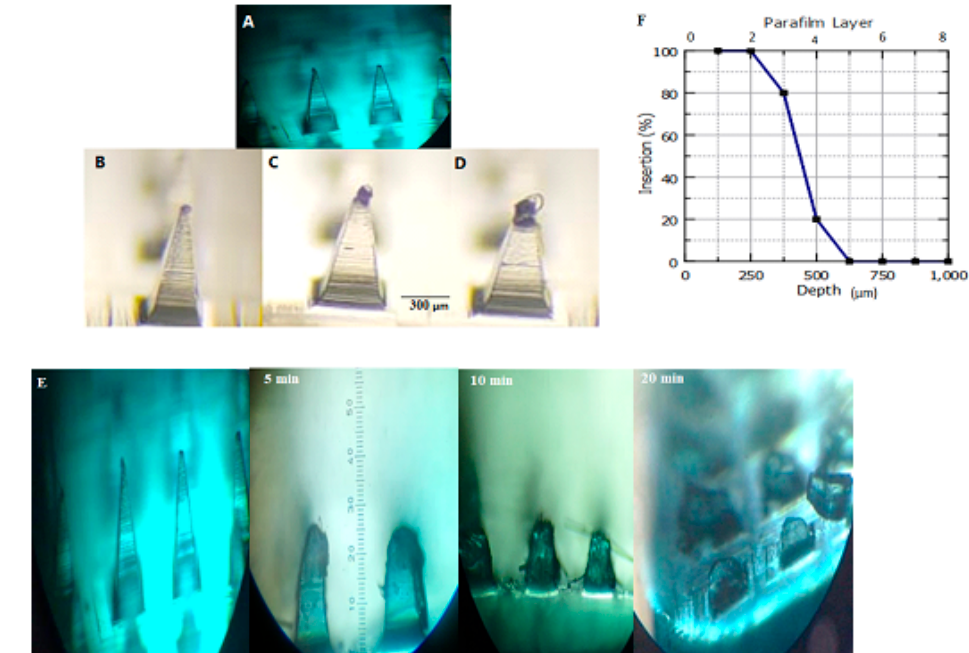
Figure 6. Polarizer photographs representing ( A ) morphology of MNs, ( B ) a decrease in the height of M4 after applying different pressures of 200 g, ( C ) 500 g, and ( D ) 1000 g, ( E ) Morphological changes of the needles after insertion into the rat skin for M4 at 5, 10, and 20 min. ( F ) Insertion depth and number of Parafilm M ® layers perforated during AA and CAFF-MN application. Table 5. The reduction in height ( µ m) of (M1, M2, M3 and M4 tested as a function of forces of 200, 500 and 1000 g per array (Mean ± SD, n =